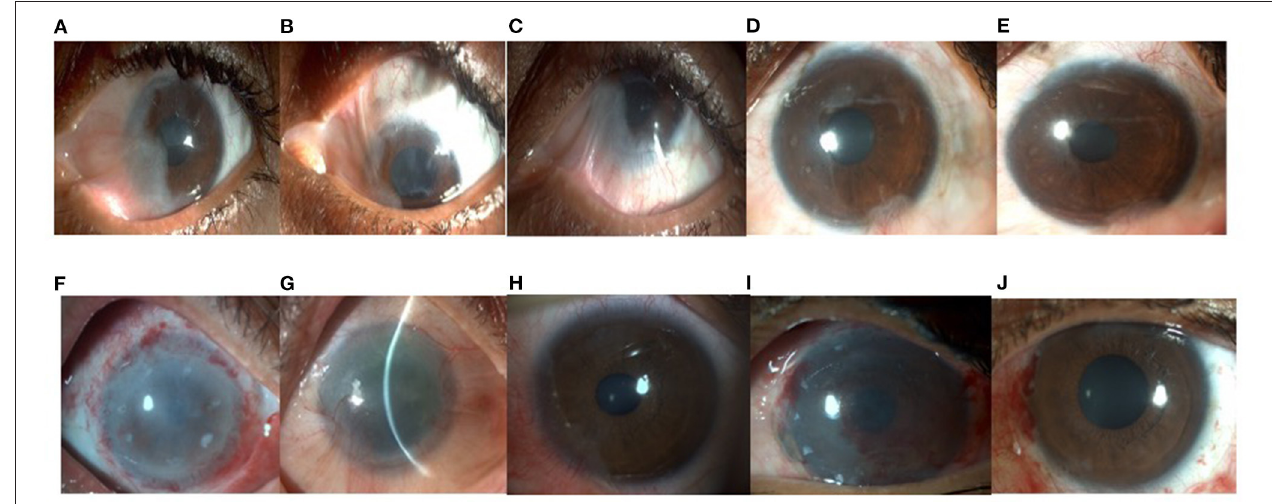
FIGURE 1 | (A) Clinical photograph of a 37 year old lady who developed partial limbal stem cell deficiency(LSCD) involving 6 clock hours of the limbus with (B) superior and, (C) inferior symblepharon in the left eye following trauma with bleaching powder. Best corrected visual acuity (BCVA) in the affected (left) eye was 20/200. She underwent symblepharon release and autologous simple limbal epithelial transplantation(SLET) in the left eye. (D) At post-operative 2 months, the patient had a well epithelised ocular surface and best corrected visual acuity of 20/30. (E) At post-operative 6 months, ocular surface was healthy, explants were seen to be fading and the patient’s BCVA was 20/20. (F) A 54 year old gentleman underwent SLET for total LSCD in the right eye following accidental injury with acid (household cleaning agent). (G) One year post operatively his BCVA was 20/30 with significant clearing of the visual axis. (H) Clinical photograph of a 24 year old boy who presented with partial LSCD following chemical injury. (I) On post-operative day 1, limbal stem cell explants can be seen well placed over the human amniotic membrane (hAM). (J) At post-operative 3 months, patient had a well epithelised, clear cornea and stable ocular